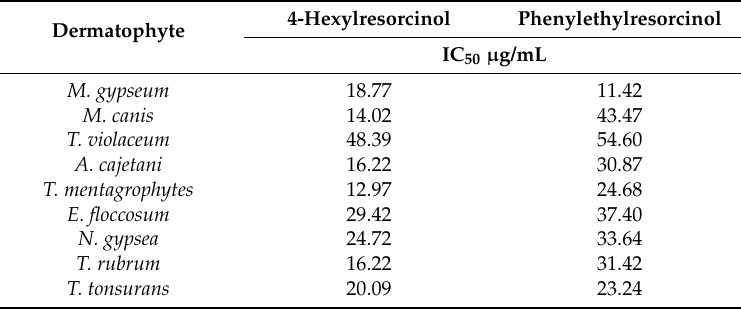
Table 3. IC 50 values of 4-hexylresorcinol and phenylethylresorcinol against nine dermatophytes. Each value is the mean of three measurements (all standard deviation values, which are not reported, were within